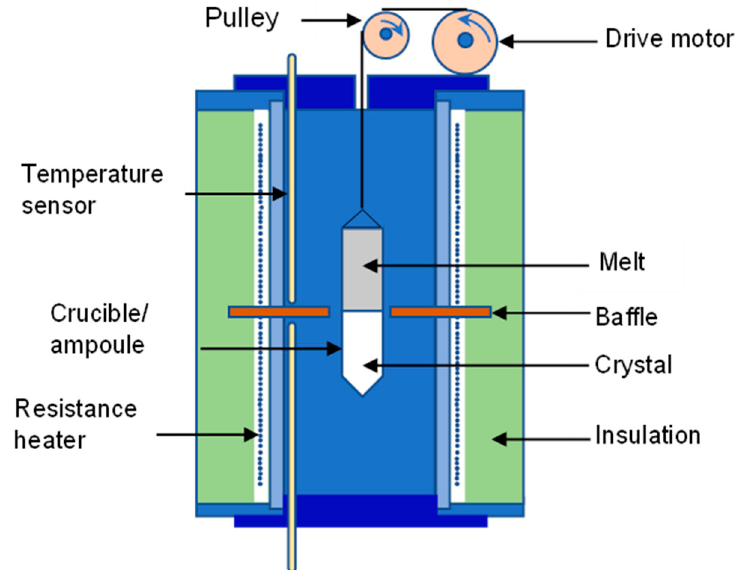
Figure 3. Bridgman technique for growing crystals.